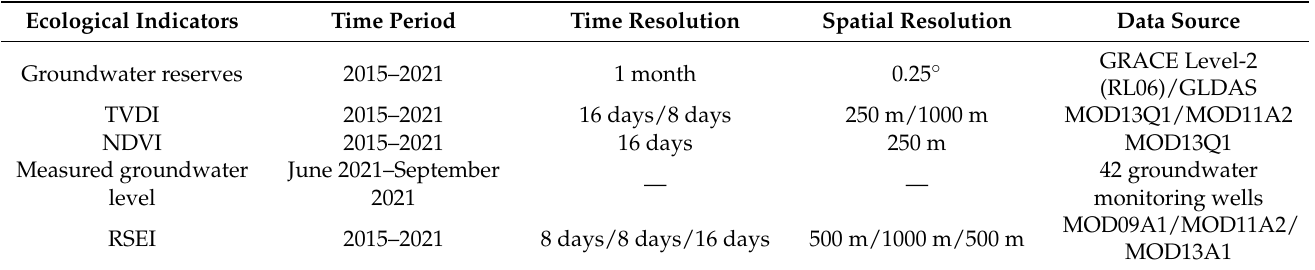
Table 1. Data and sources used by the